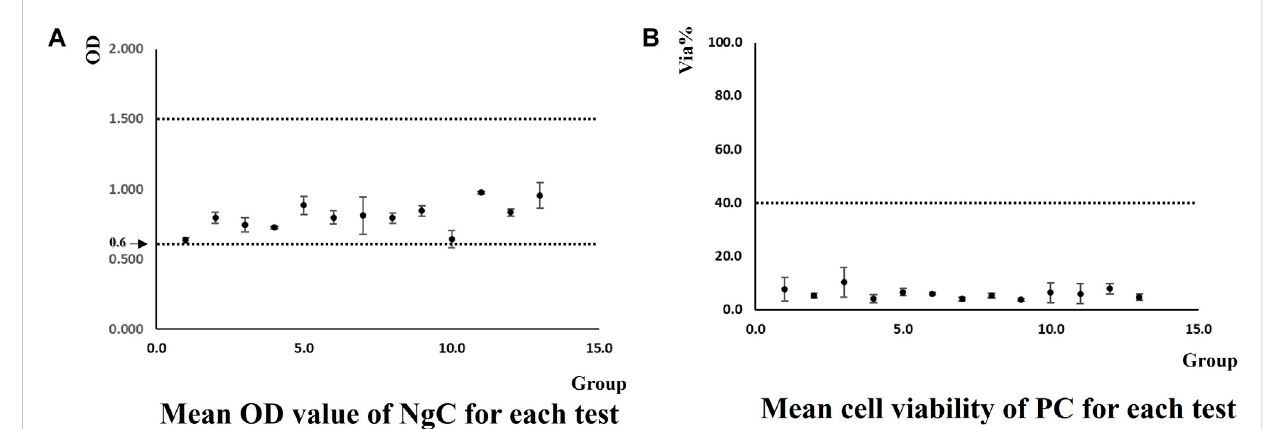
FIGURE 2 Mean OD of NgC and via % of PC generated by two laboratories in the method implementation process.